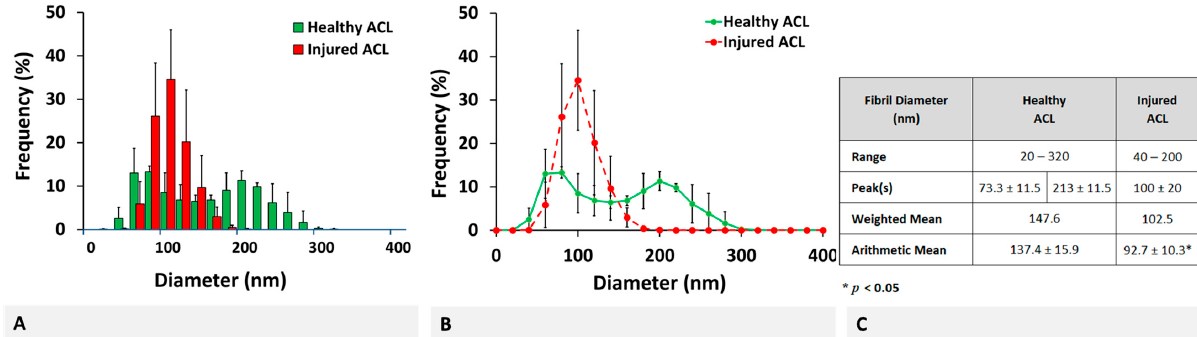
Figure 2. Diameter distribution of collagen fibrils from ( A ) healthy and ( B ) injured ACL tissue and respective ( A1 – A3 , B1 – B3 ) transmission electron microscopy (TEM) images. ( A1 – A3 ) correspond to specimens obtained from ACL tissue of each healthy subject ( n = 3). ( B1 – B3 ) correspond to specimens obtained from ACL tissue of each injured subject ( n = 3).